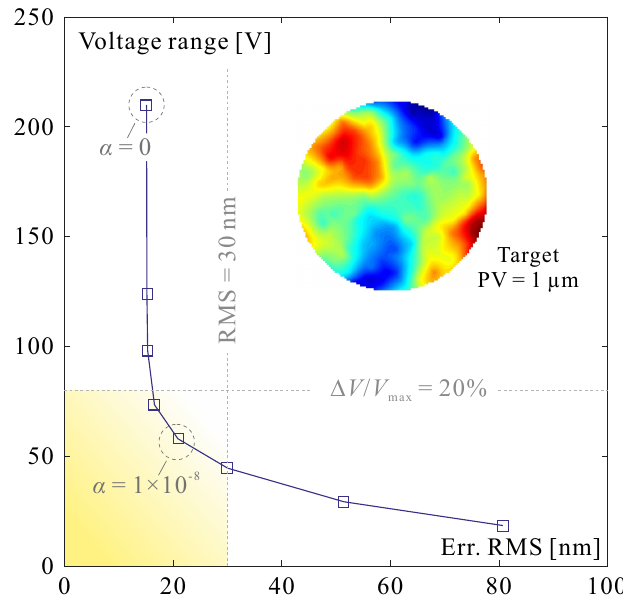
Figure 2. L-curve for the damped least squares: Voltage range ∆ V vs. root mean square (RMS) residual surface figure error for various values of the damping coefficient α